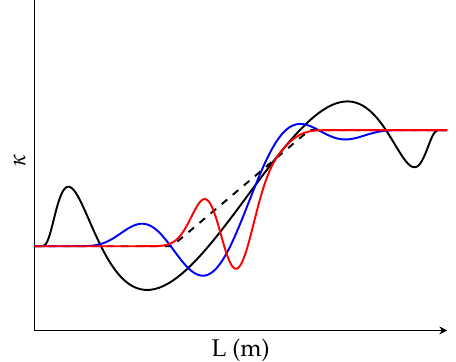
Figure 15. Curvature plots of the clothoid with parts of the circular segments (dashed) and blending splines in [ p 3 , q 3 ] for slope parameters β = 1.0 (black, default), β = 8.0 (blue), and β = 50.0 (red).